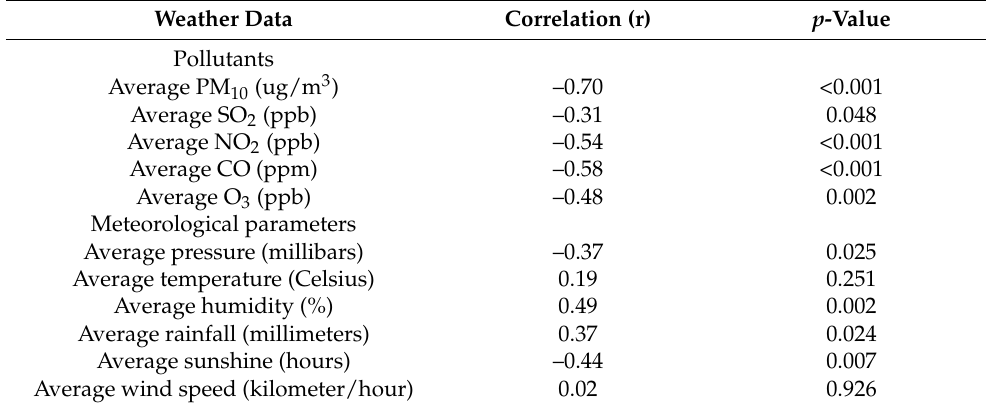
Table 3. Correlation between Weather Data (Pollutants and Meteorological parameters) and Asthma Control Test (ACT)